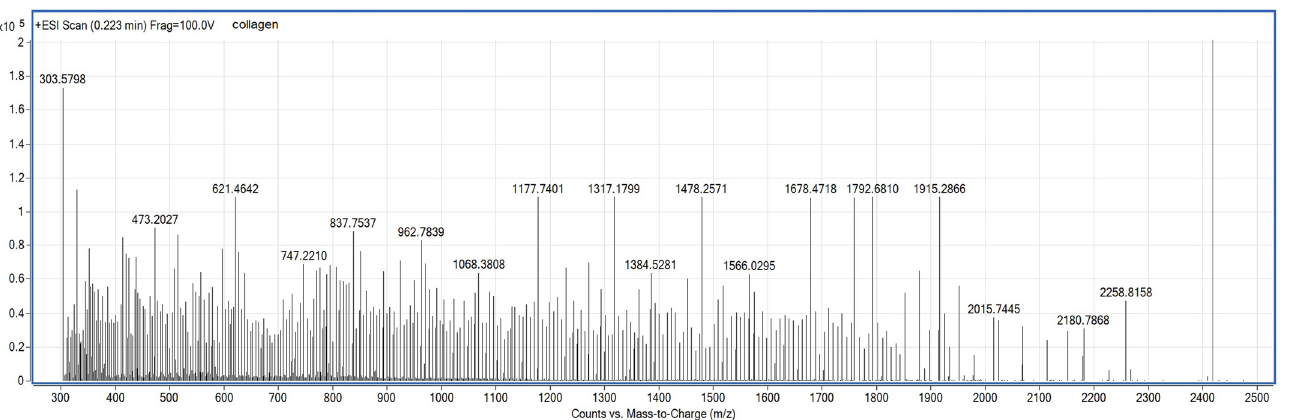
Figure 3. Analysis of chitosan solution reticulated with acetic acid after 24 h of maturation.